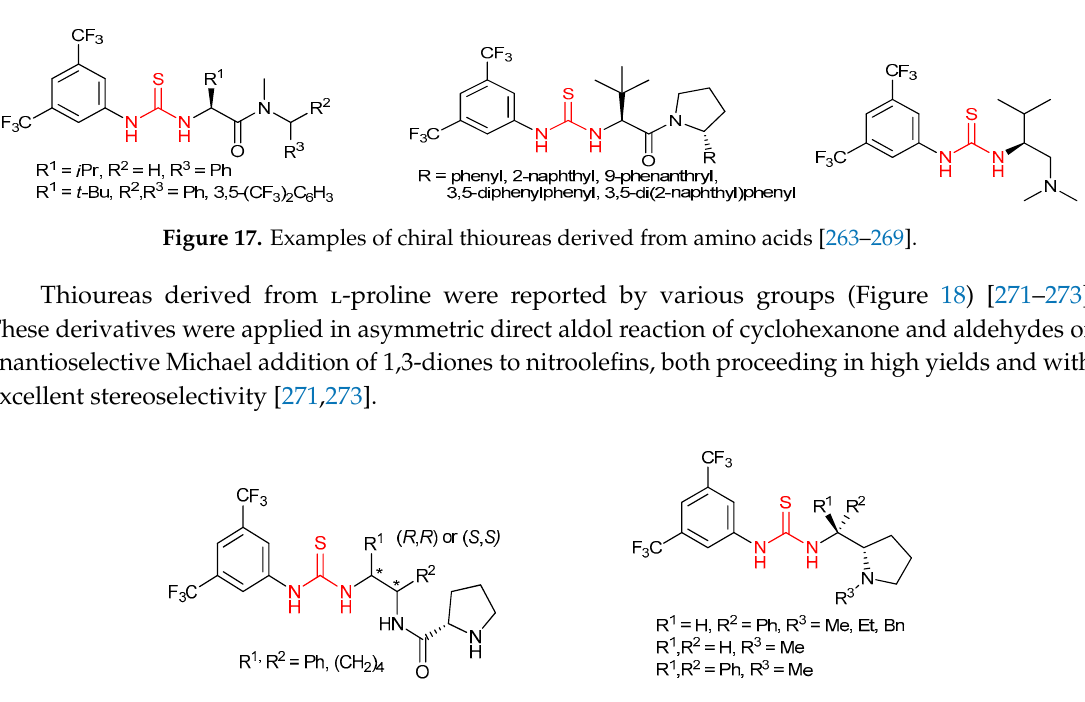
Figure 18. Chiral thioureas obtained from L -proline [271–273].